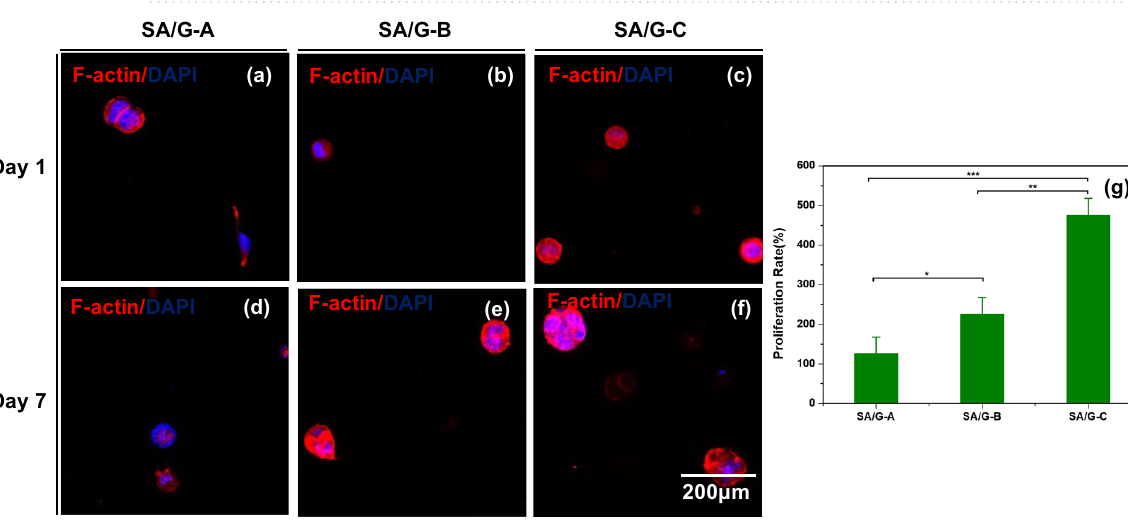
Figure 7. Cytoskeleton staining of the cell-laden scaffolds. Cytoskeleton staining view on day 1 ( a – c ) and on day7 ( d – f ). ( g ) Cell proliferation rate on day 7 after printing. All data are displayed as mean ± SD. ***indicates p < 0.0001, **indicates p < 0.001, *indicates p < 0.05, analysed via Welch’s t